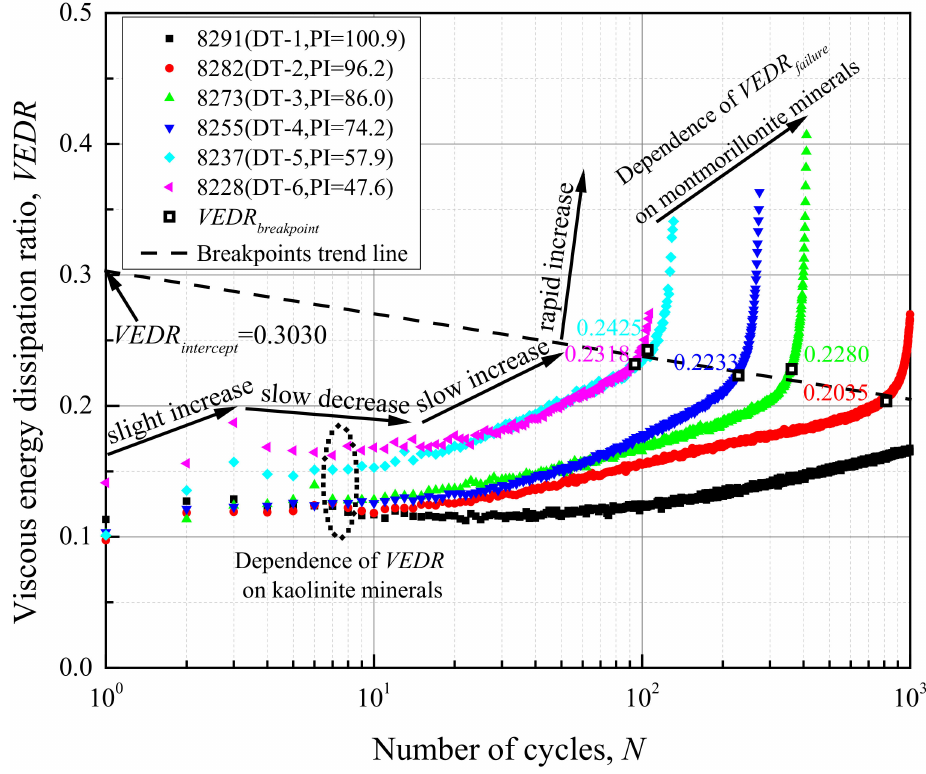
Figure 14. Relationship between number of cycles and VEDR for artificial marine